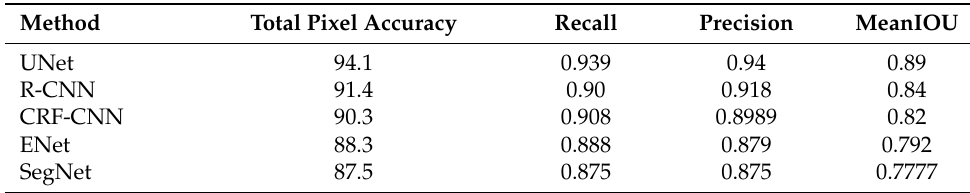
Table 4. Comparison of UNet with Other